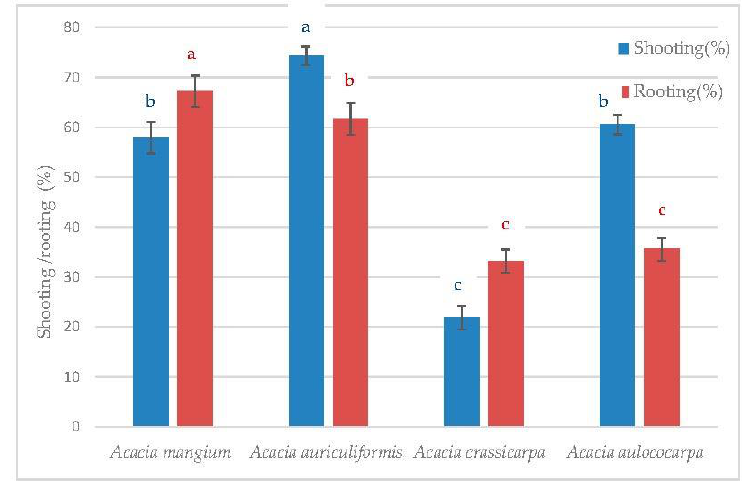
Figure 2. Shooting and rooting percentage of rejuvenated stem cuttings of Acacia species. Note: bar = ± standard error of the mean, Means of each variable with the same letters are not significantly different at p ≤ 0.05.